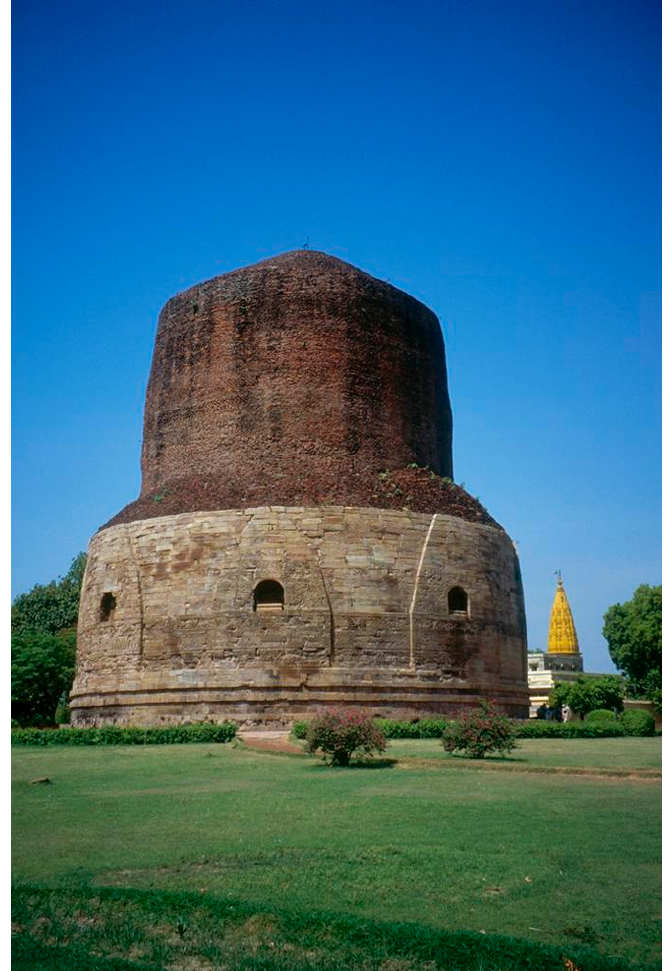
Figure 9. Dhamekh Stupa at S ā rn ā th, India. Ca. fifth century (restored and modified in the twentieth century. [©Rob Linrothe, Northwestern University].